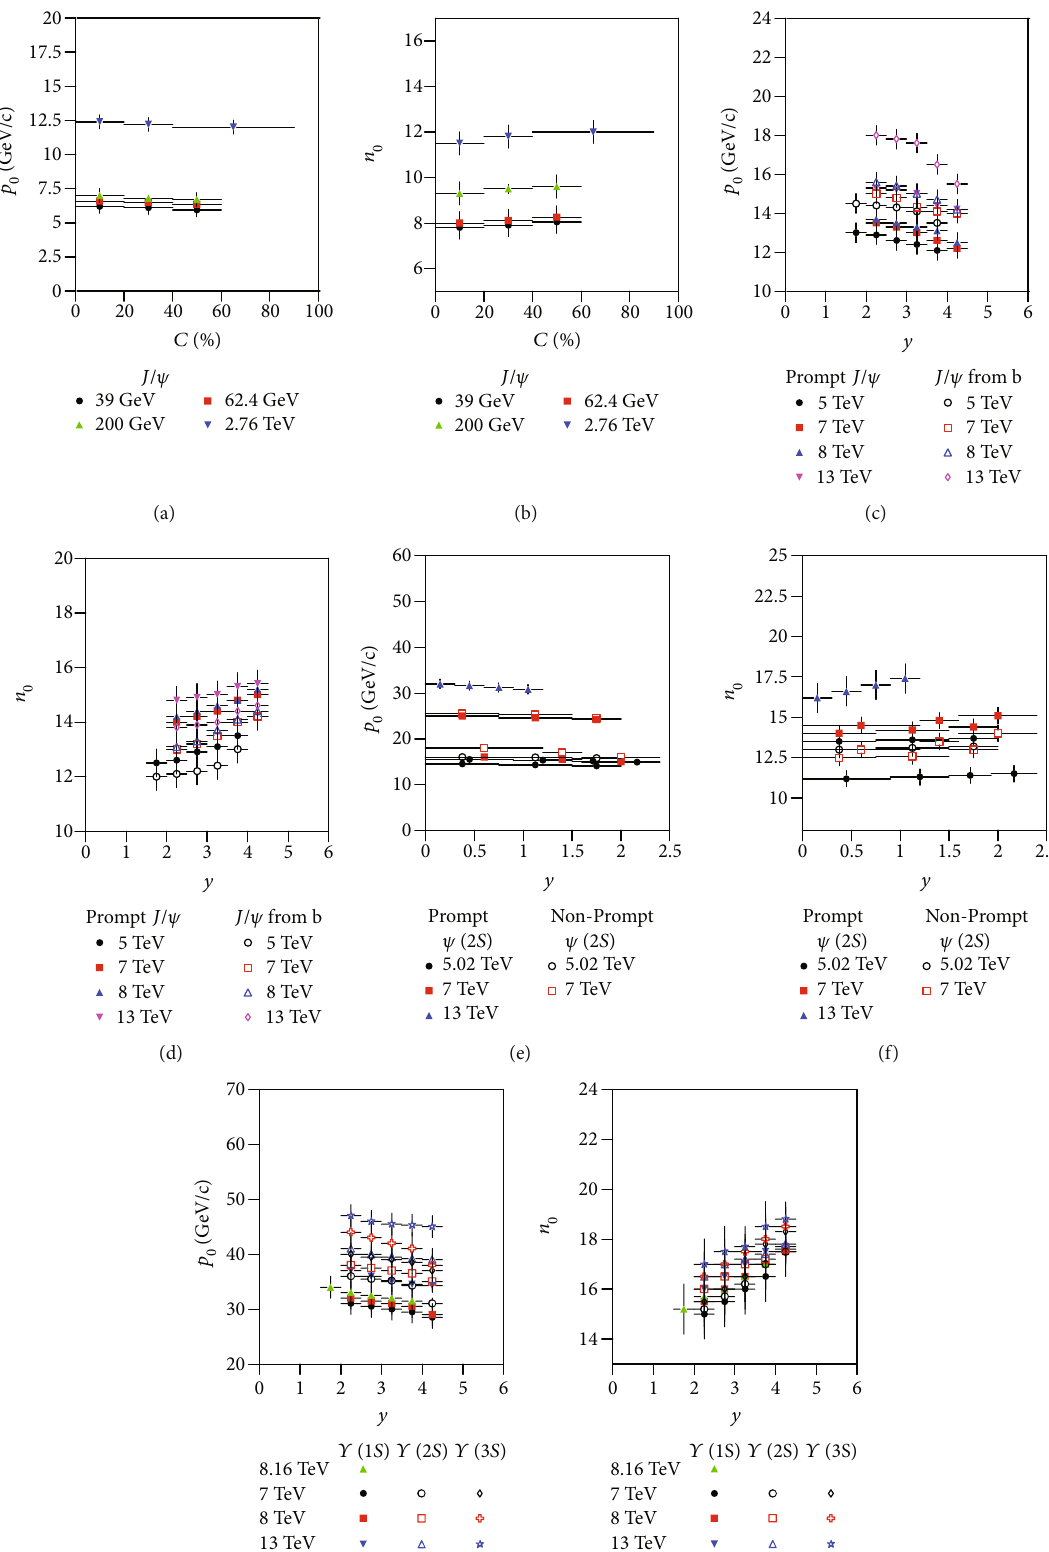
n C and (c – h) y for (a – d) J / ψ , (e, f) 0 on (a, b) 0 and (b, d, f, and h)